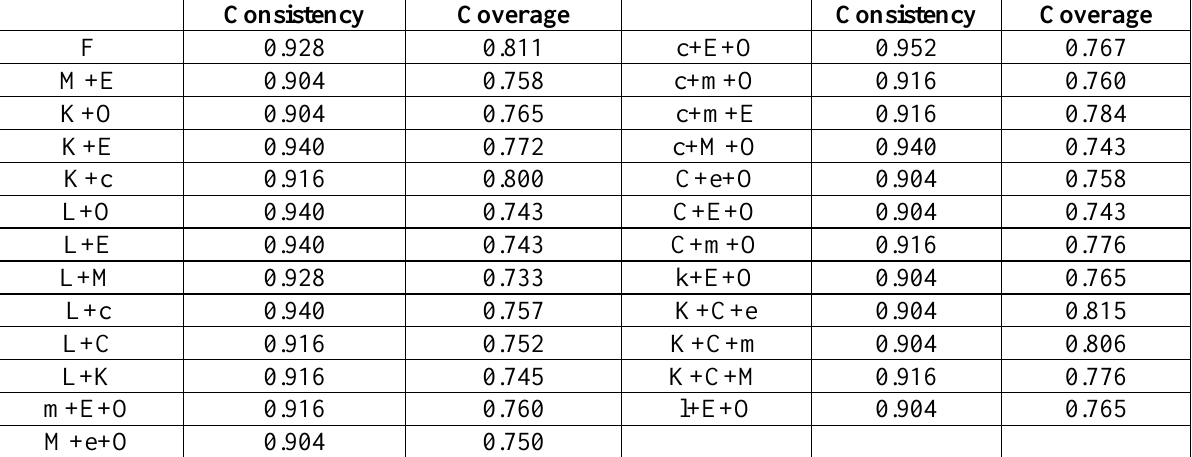
Table A3.5. Results of the fsQCA for the analysis of necessity for the group success. L=Leader, K=Knowledge generator, C=Connector, F=Follower, M=Moralist, E=Enforcer, O=Observer.